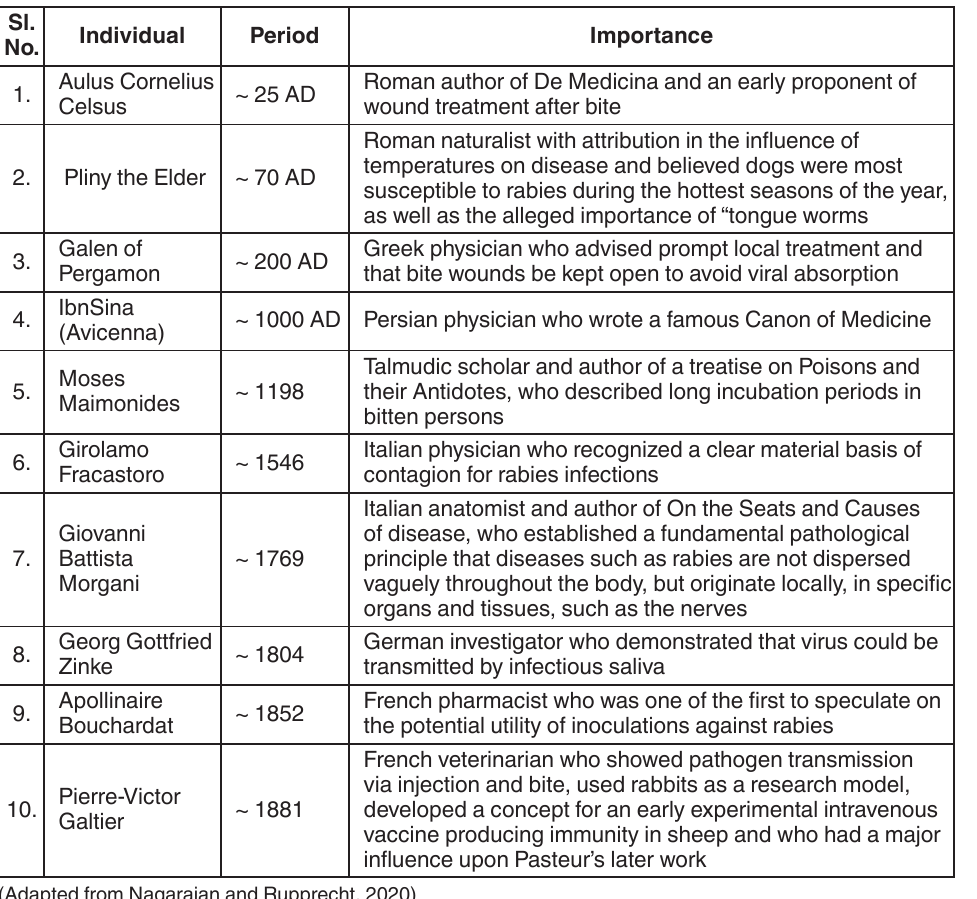
table 1. Pre- Pasteurian personalities related to rabies sl.